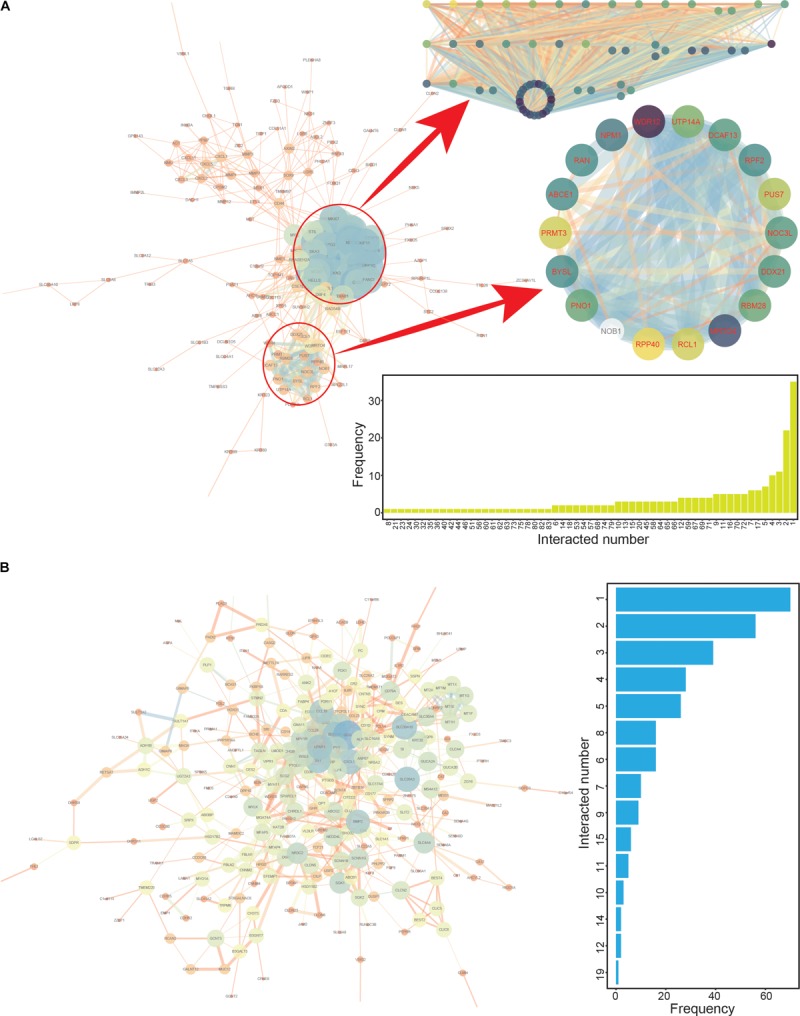
The protein-protein interaction (PPI) networks constructed based on up- and down-regulated genes. (A) The PPI interaction network based on up-regulated genes, with two specific modules highlighted. The numbers of interacting genes are also presented. (B) The PPI interaction network based on down-regulated genes. The numbers of interacting genes are also presented.